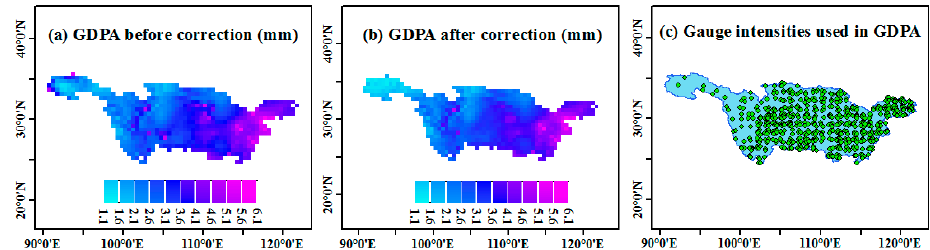
Figure 2 . Spatial distribution of averaged gridded daily precipitation analysis (GDPA) ( a ) before check, ( b ) after check with correction, and ( c ) of gauge intensities used in the optimal interpolation.